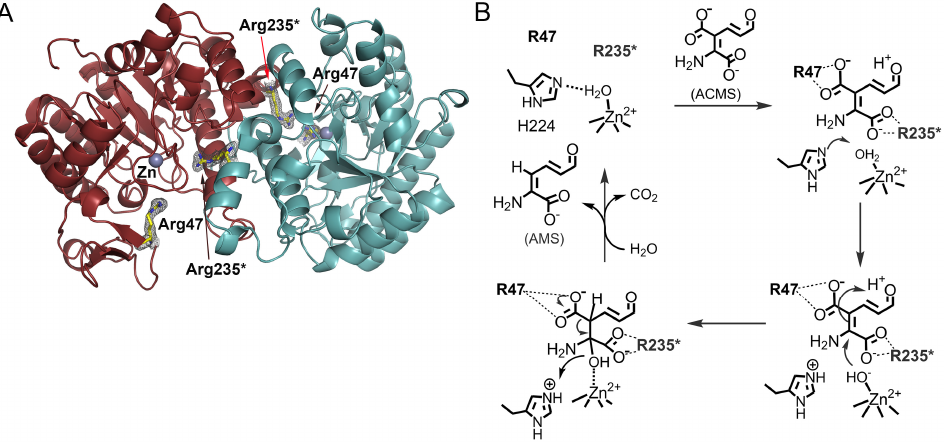
Figure 3. ( A ) The crystal structure of human ACMSD shows a homodimer with an essential Arg235 in the active site from a neighboring subunit (PDB: 4OFC). ( B ) The catalytic cycle of ACMS decar- boxylation. For more information, see References [59–62].